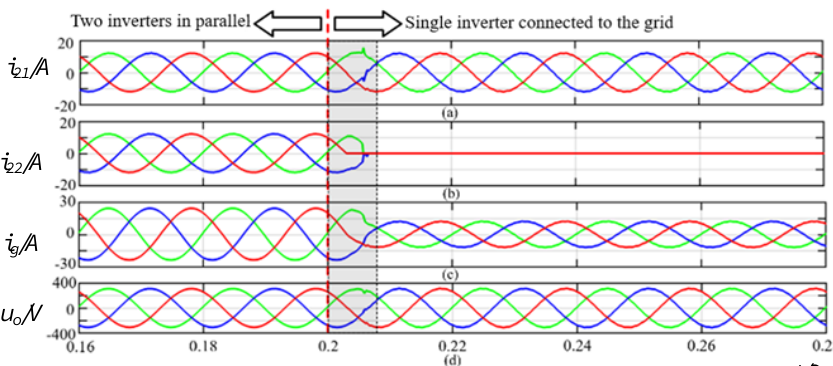
Figure 12. Simulation results of a group of parallel inverters with the same capacity cutting off an inverter: ( a ) current waveform of inverter 1; ( b ) current waveform of inverter 2; ( c ) total current waveform; and ( d ) voltage waveform of PCC.